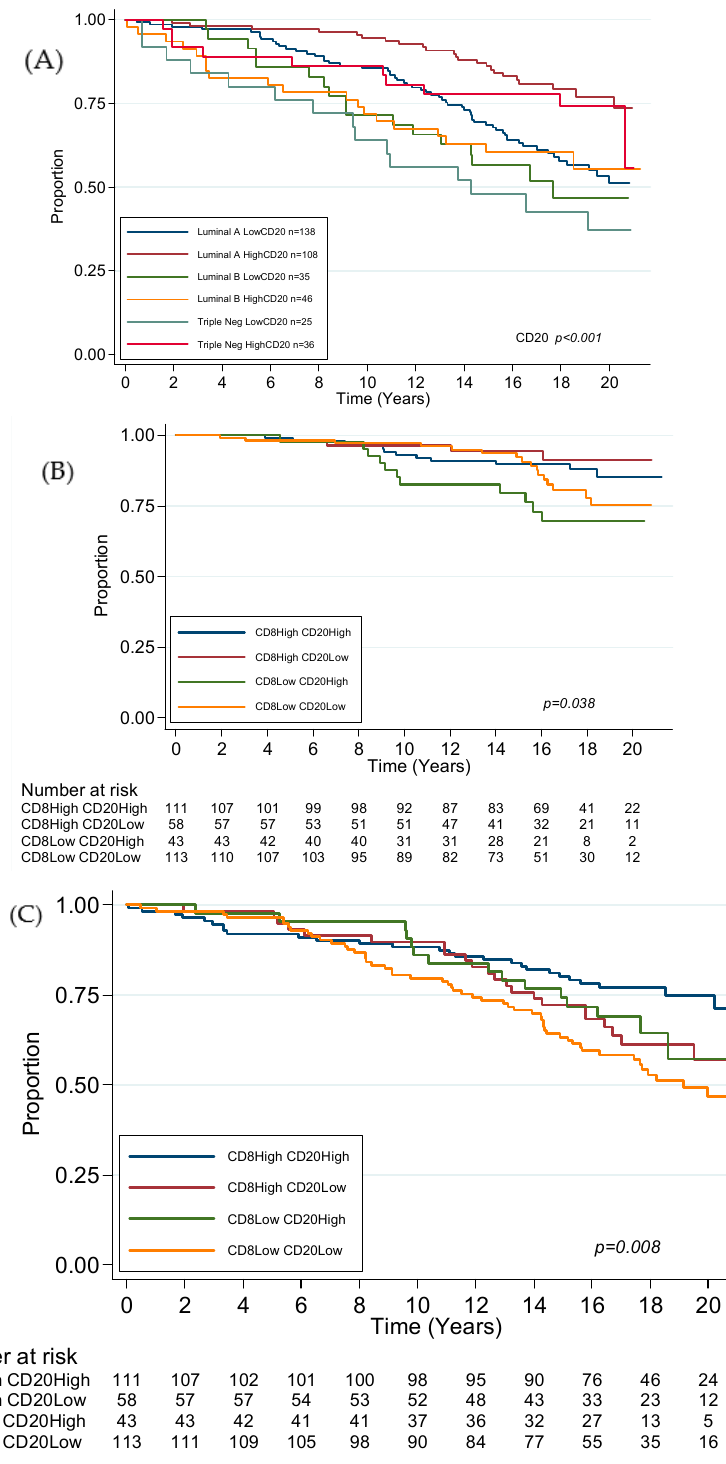
Figure 6. ( A ) Kaplan–Meier estimates for overall survival in the whole cohort stratified by CD20 expression; combined CD8 and CD20 expression in luminal-only tumours for ( B ) local recurrence and ( C ) overall survival.